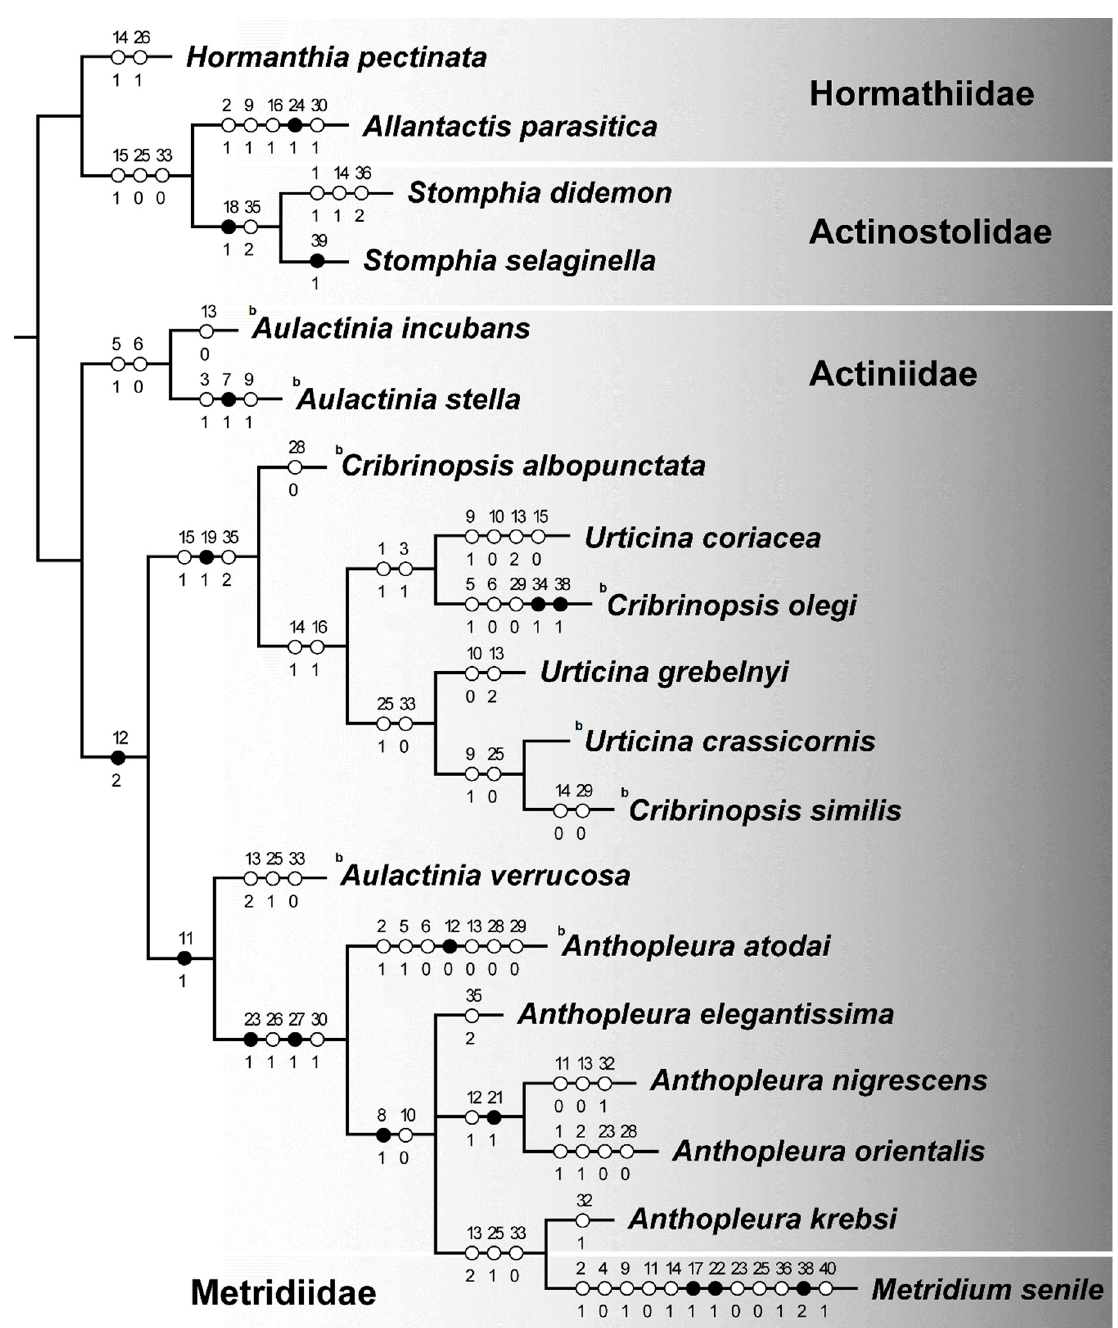
Figure 4. Maximum parsimony tree based on morphological and ecological data. The letter b indicates the species with the brooding strategy.